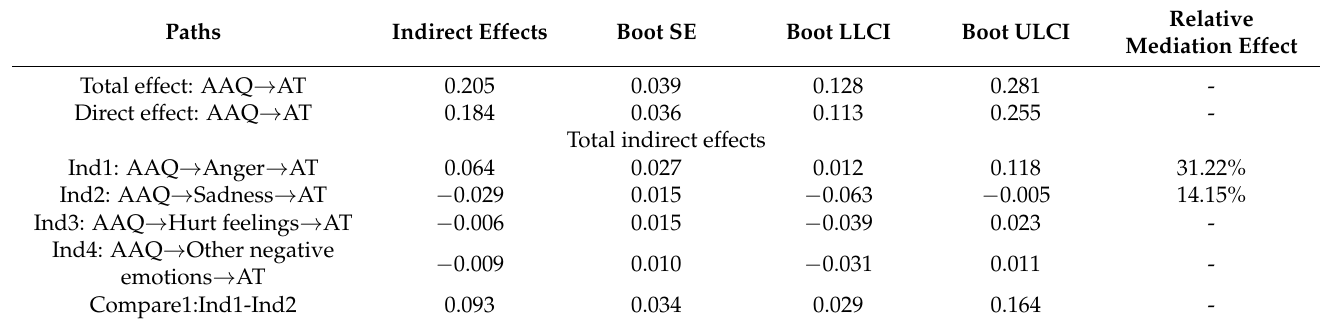
Table 3. The results of parallel mediation analysis of negative emotions following social exclusion.